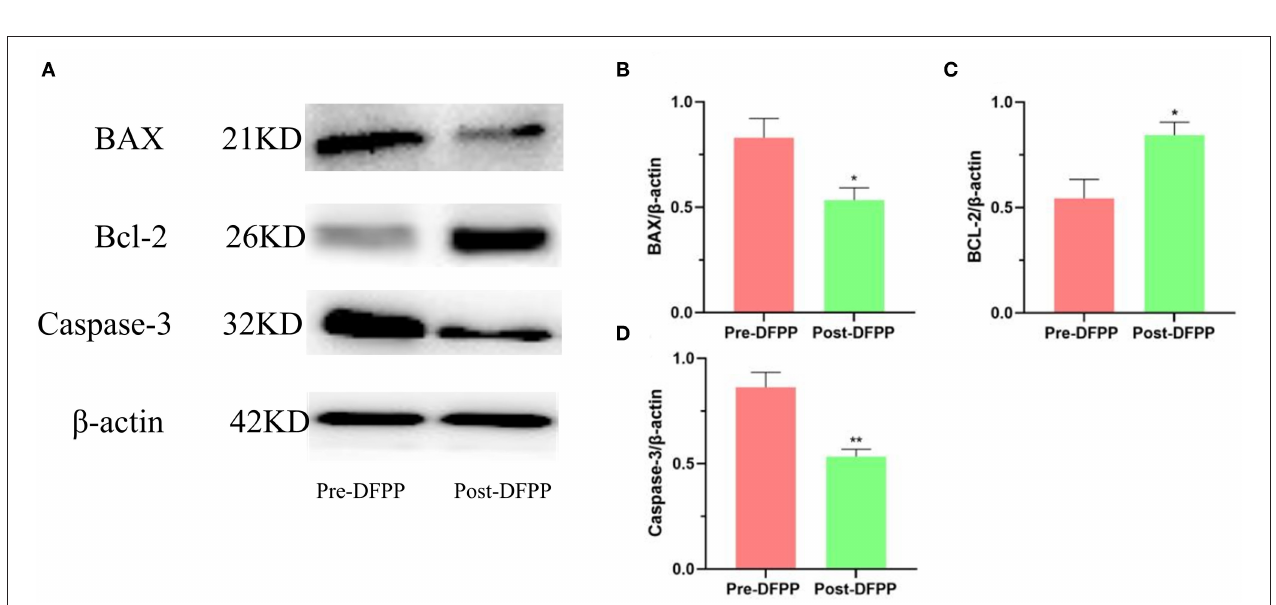
FIGURE 2 | DFPP affects ER stress-related proteins. PBMCs protein samples are extracted from patients with high cholesterol and/or high LDL-C. (A) Westernblot result picture of ER stress-related proteins. ER stress-related proteins [GRP78 (B) , ATF4 (C) , CHOP (D) , p-EIF2 α (E) ] in PBMCs were detected by Western blot analyses. Values were expressed as mean ± SD. * P < 0.05 and ** P < 0.01 vs. pre-DFPP. N = 5.